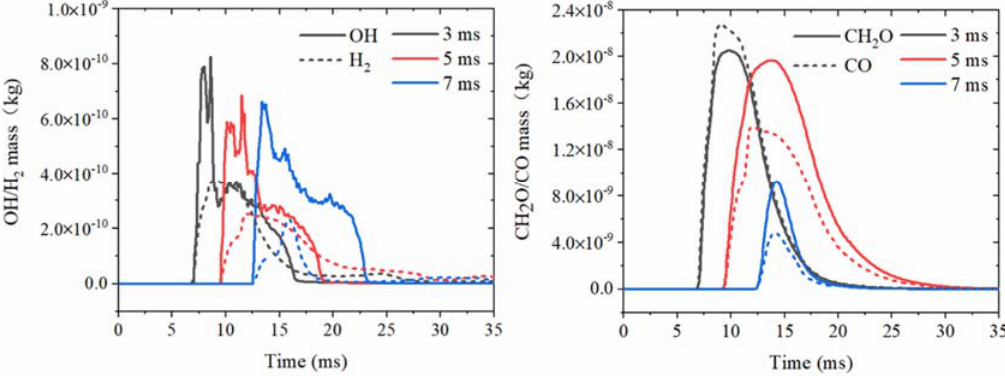
Figure 8. Major species mass traces of jet for different spark timings.